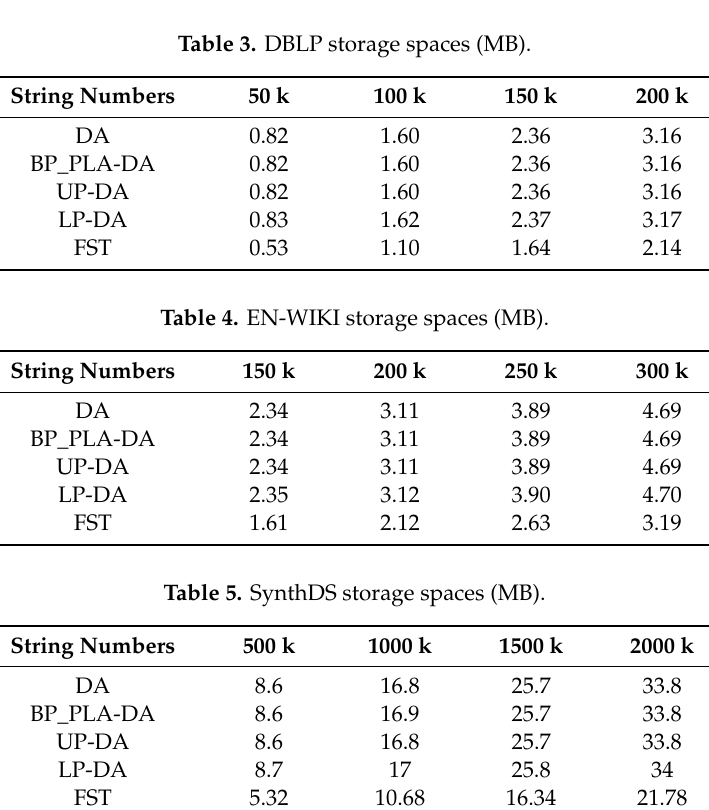
Figure 11. Retrieval times for different number of strings.